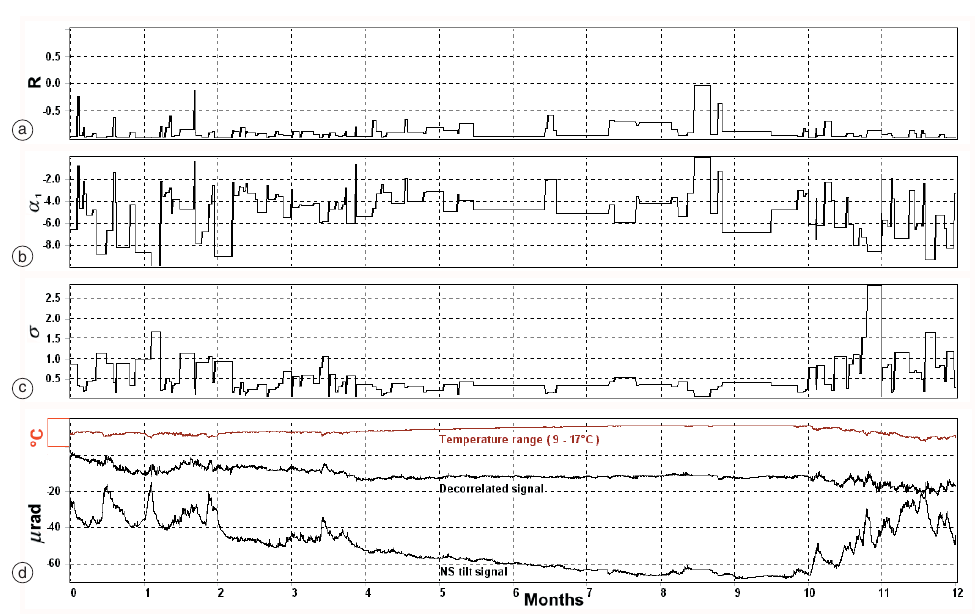
Fig. 14a-d. The thermal correction is applied to the NS tilt component recorded by DMB in 2001. The decor- related signal undergoes a contraction in comparison to the original signal showing an inclination towards S